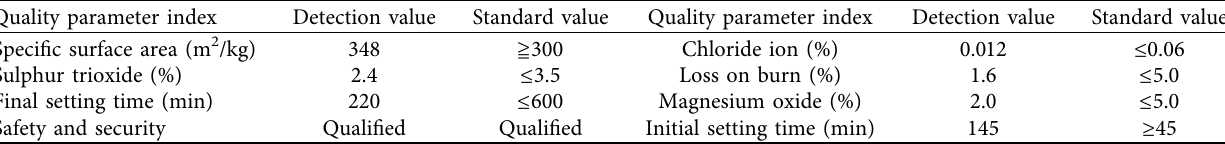
Table 1: P.O 42.5 cement quality parameters.